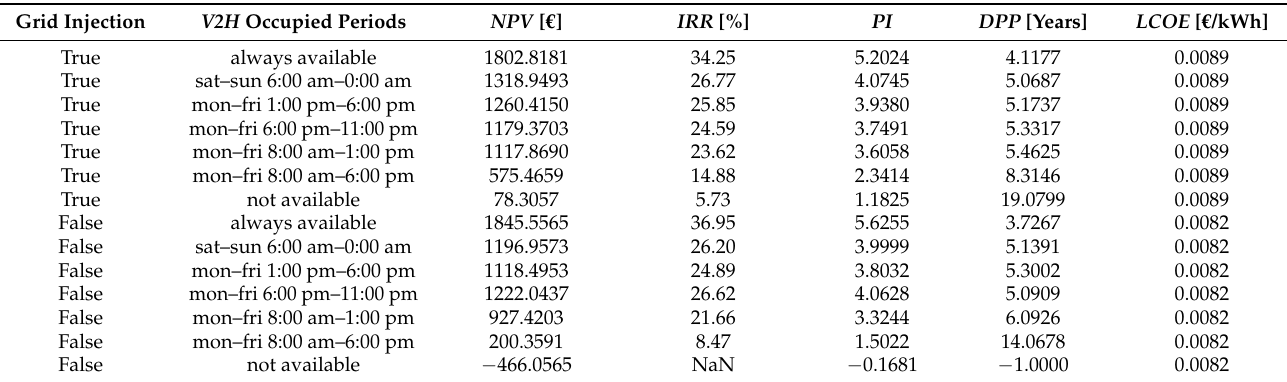
Table 5. Economical results for 0.5 kWp PV